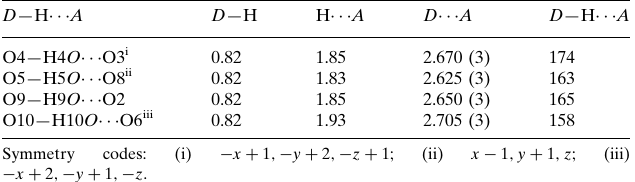
Hydrogen-bond geometry (A˚ , (cid:3)